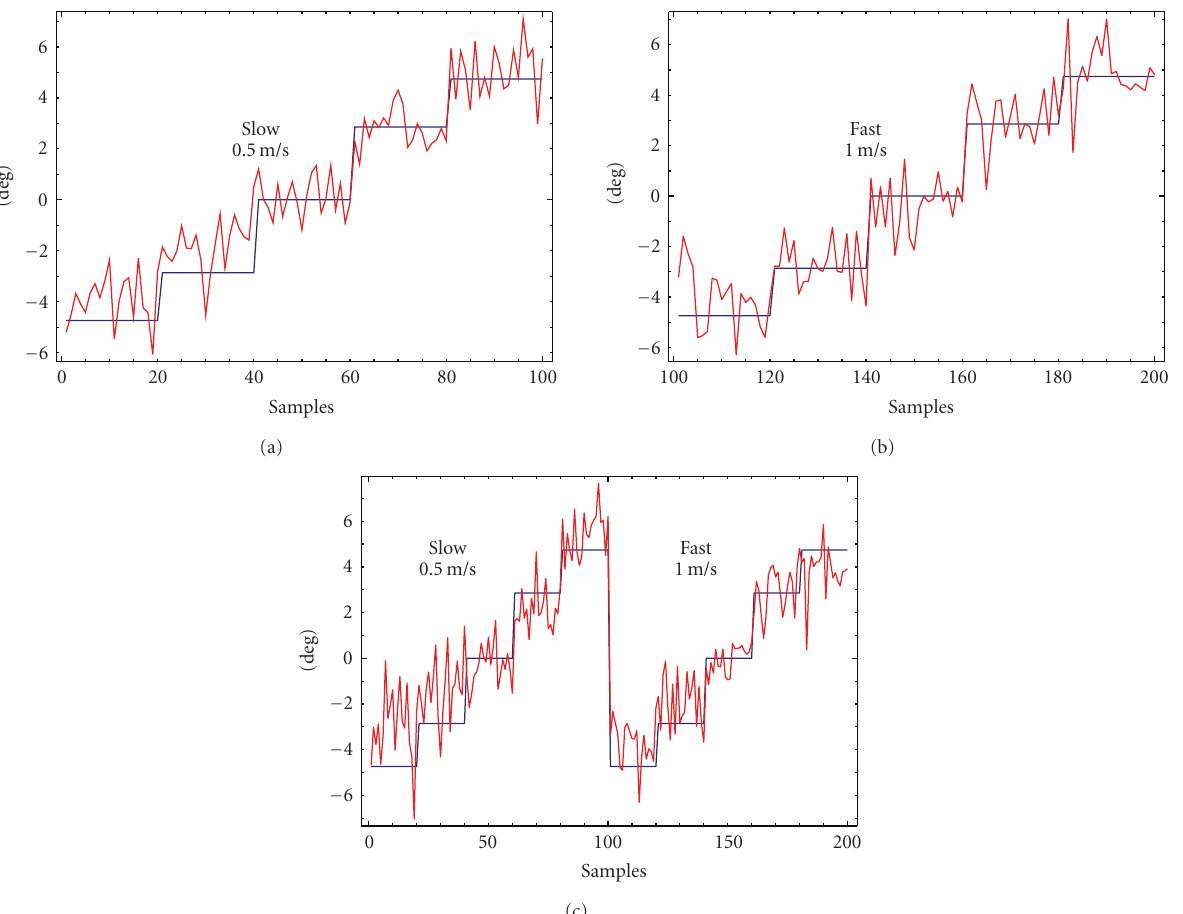
Figure 6: Ground angle estimation for subject B, tuned for (a) slow speed, (b) fast speed, and (c) slow + fast